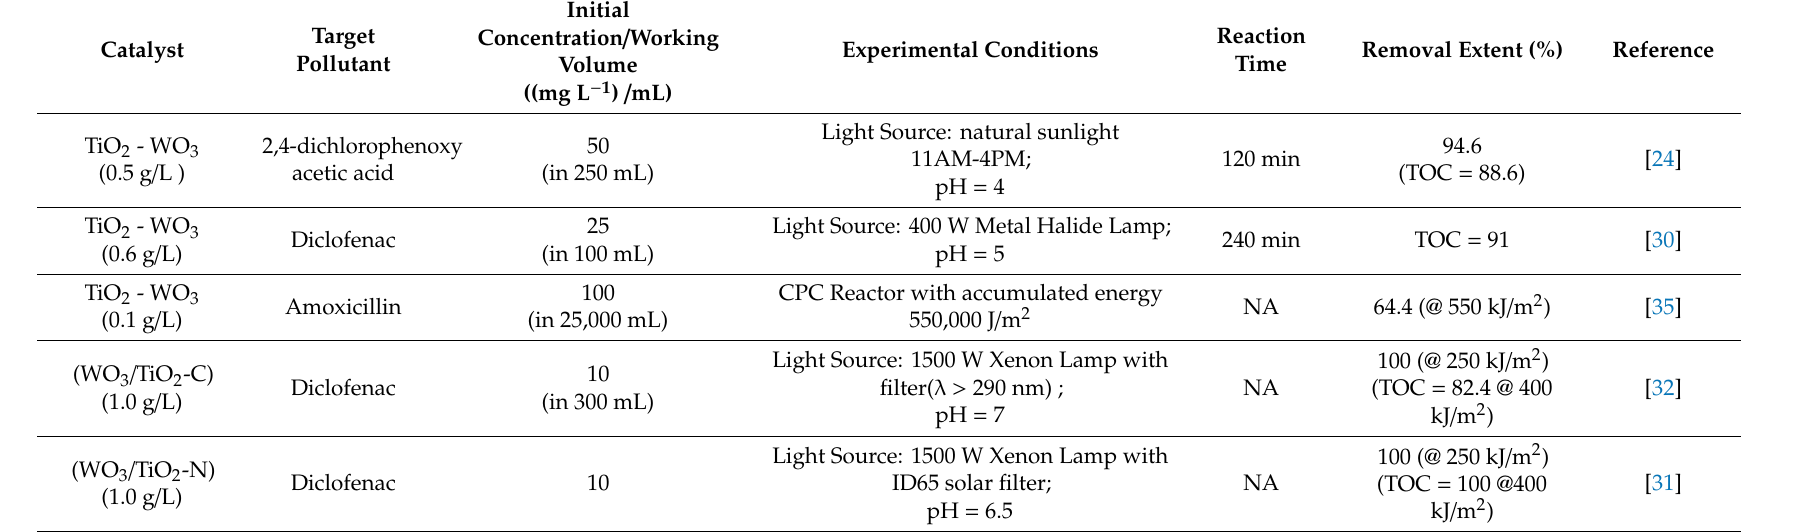
Table 1. Photocatalytic degradation of contaminants of emerging concern (CECs) over TiO 2 / WO 3